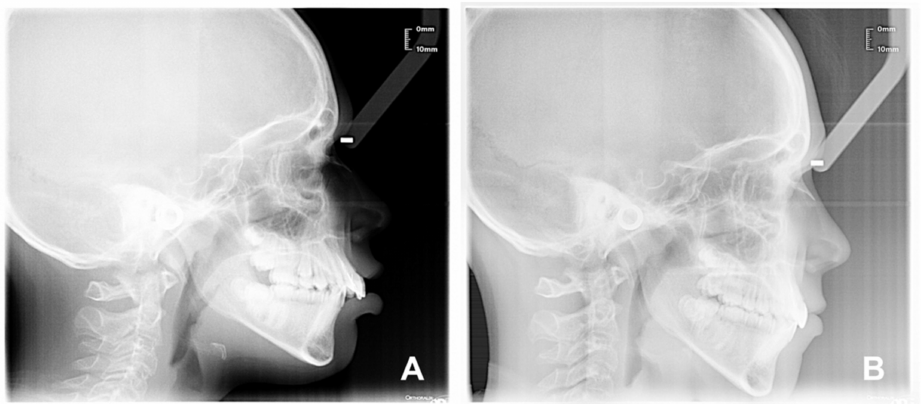
Figure 5. ( A , B )—Patient (V.M.) latero-lateral teleradiography X-ray: before treatment T0 ( A ); and after treatment T1 ( B